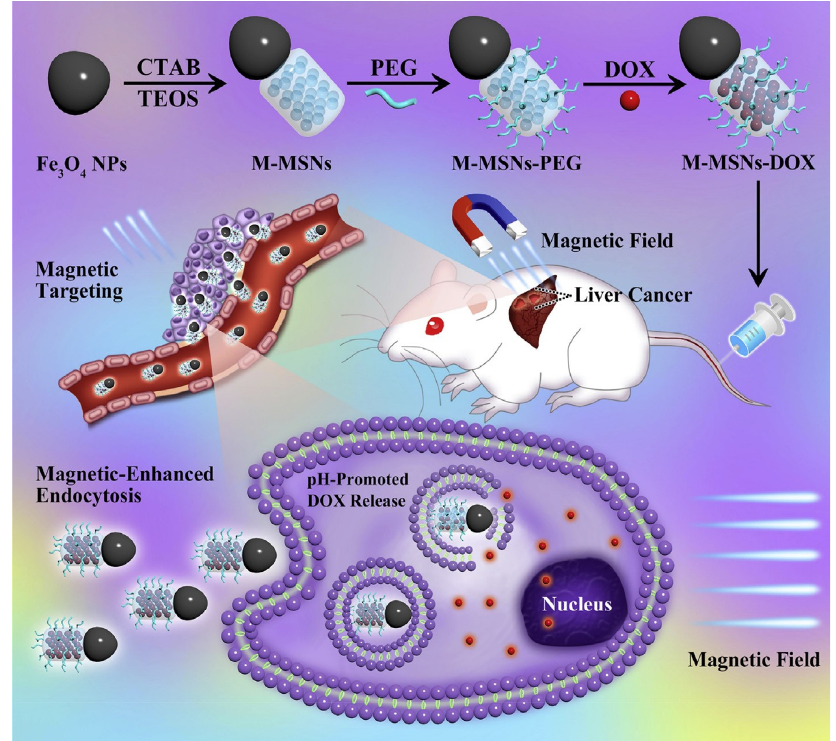
Figure 13. Schematic illustration of the synthetic procedure for the Janus M-MSNs-DOX nano-bullet and application for pH-promoted drug release after magnetic-enhanced endocytosis in cancer cells, as well as magnet targeting liver cancer chemotherapy in vivo (Reprinted with permission from Ref. [169]. 2016, Dan